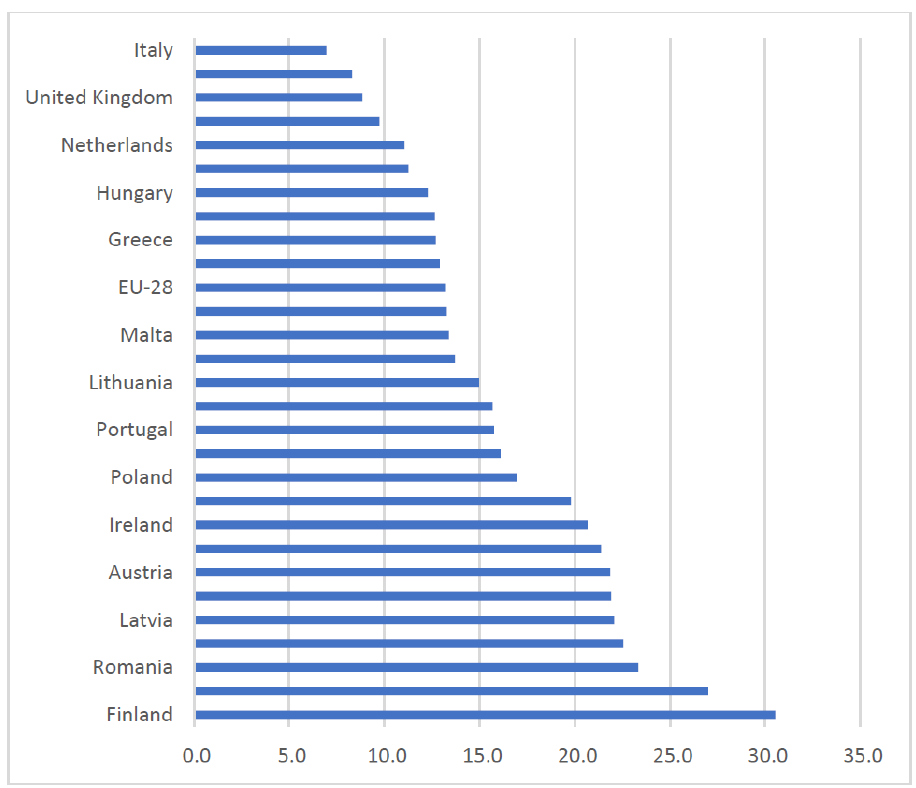
Figure 3. Material footprint—domestic material consumption. Source: Own representation based on Eurostat data [32] .